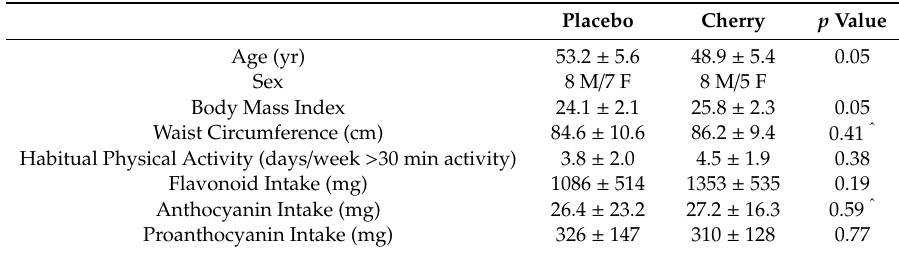
Table 1. Participant Baseline Characteristics.